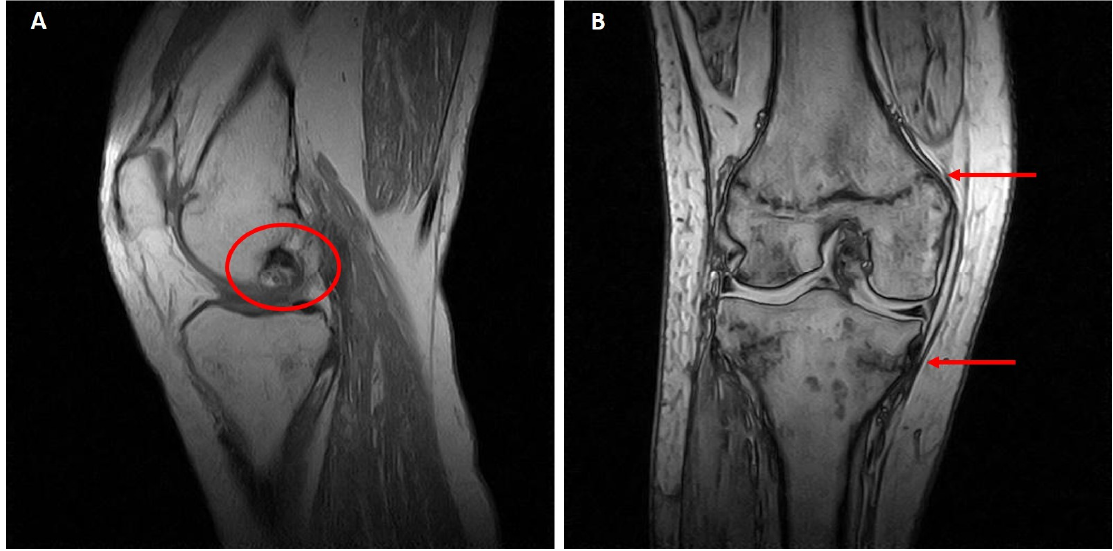
Figure 2. Right knee MRI (July 2016). ( A ) Osteonecrotic area of about 2 cm in the external femoral condyle. ( B ) The arrows indicate femoral and tibial metaphyseal